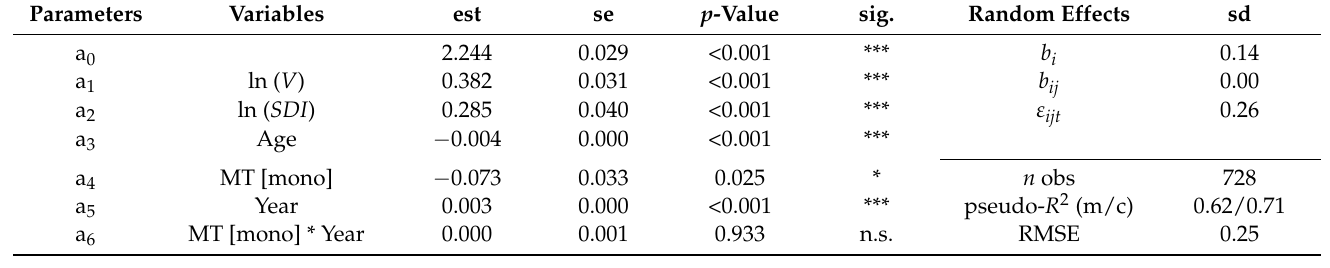
Table 4. Results of the linear mixed effects model on long-term stand productivity (Equation (8)); est—